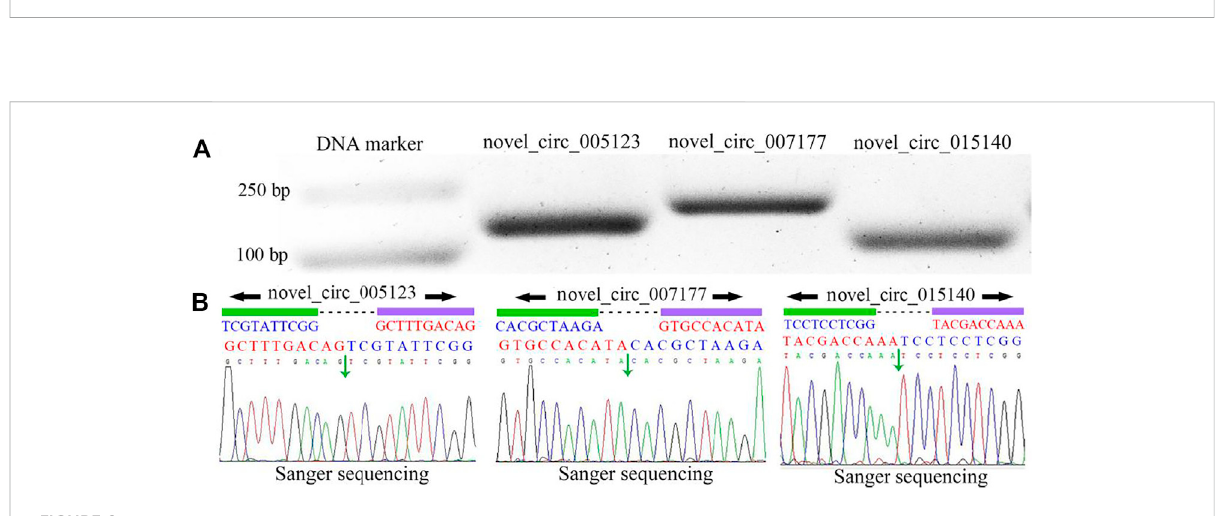
FIGURE 2 PCR ampli fi cation (A) and Sanger sequencing (B) of three A. c. cerana circRNAs. Black arrows indicate the direction of primers for PCR ampli fi cation, and green arrows indicate back-splicing sites within